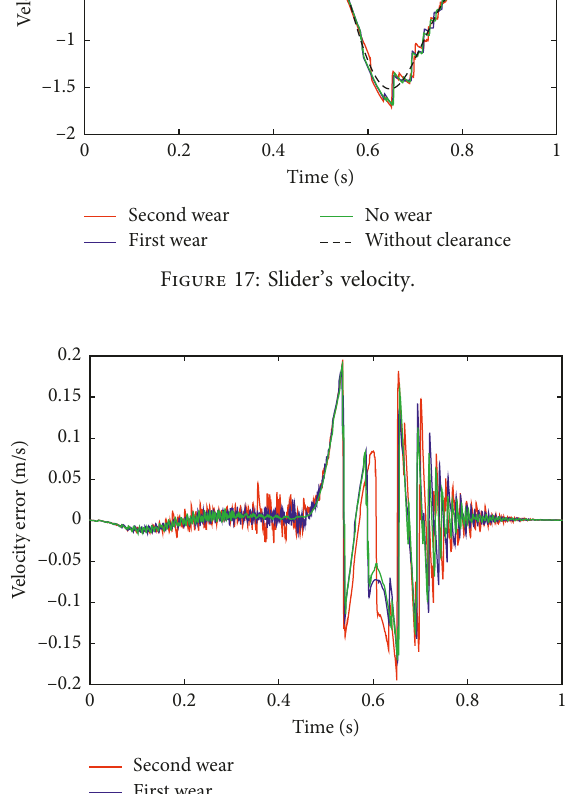
Figure 18: Slider’s velocity error.